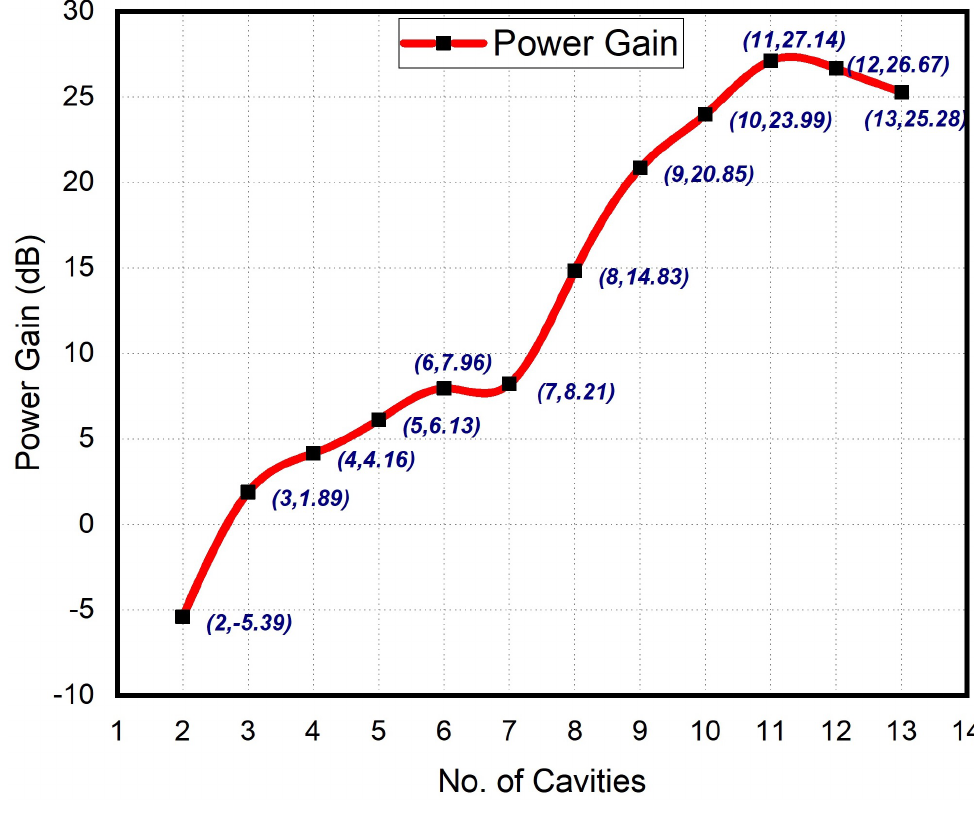
Figure 6. Plot of output power gain vs total number of